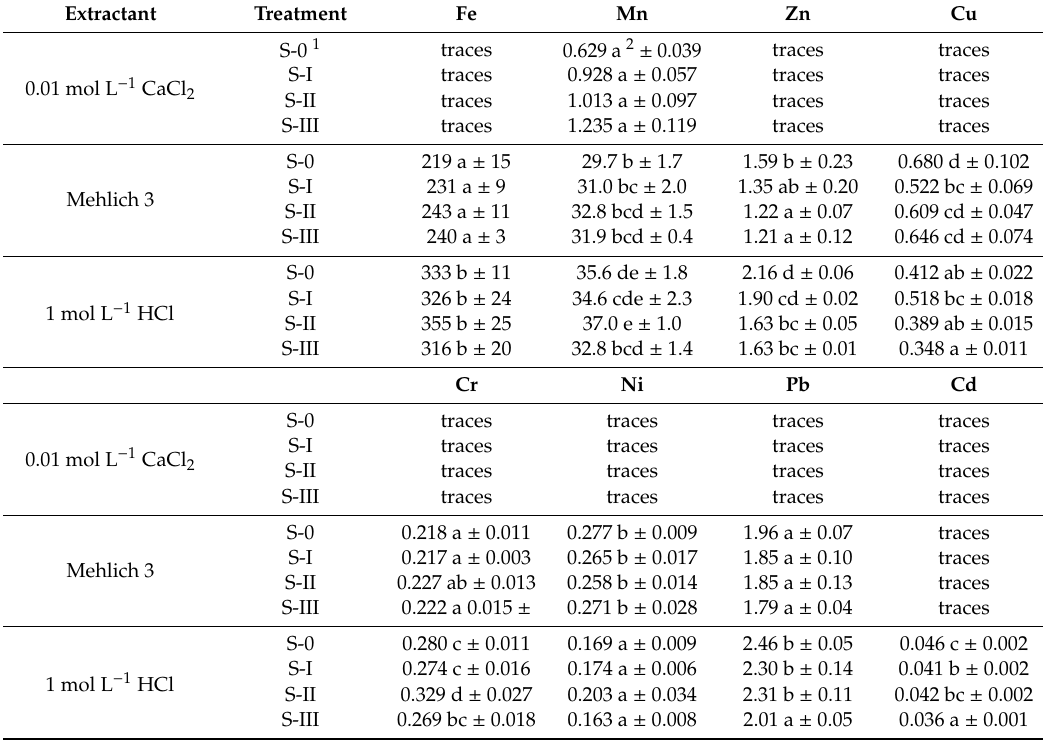
Table 5. Content of available forms of selected heavy metals in light soil 60 days after sulfur introduction (mg kg − 1 d.m. ± SD).